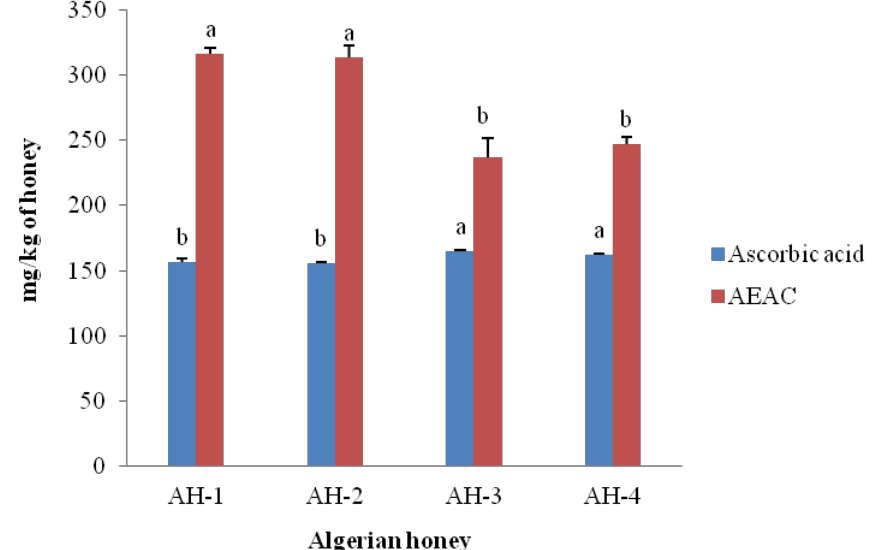
Values with different letters indicate significant differences ( p <